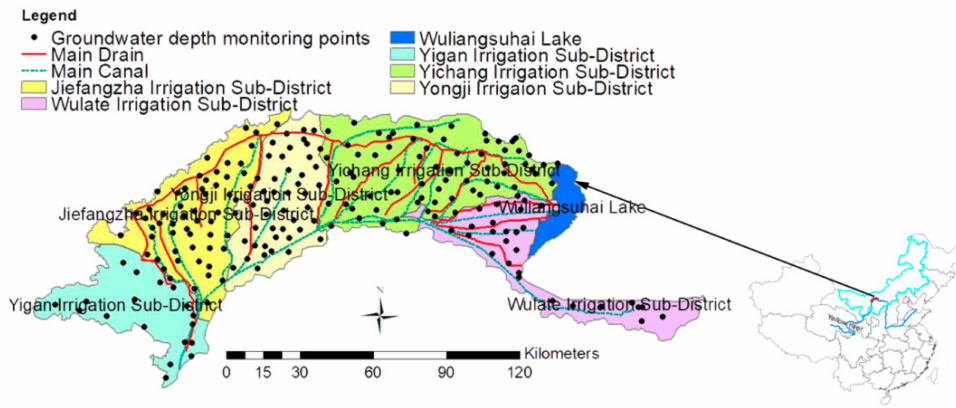
Figure 1. Location of the study